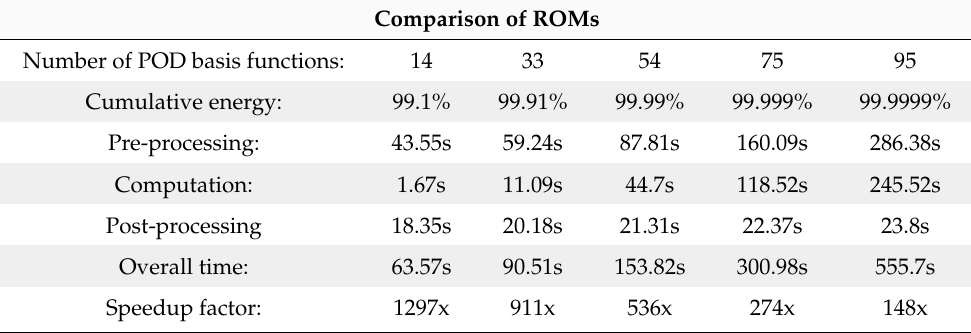
Table 1. Comparison of ROMs calculated with different values of the POD velocity space dimension. The higher the number of POD basis functions is, the more accurate the results are, but with a decrease in the speedup